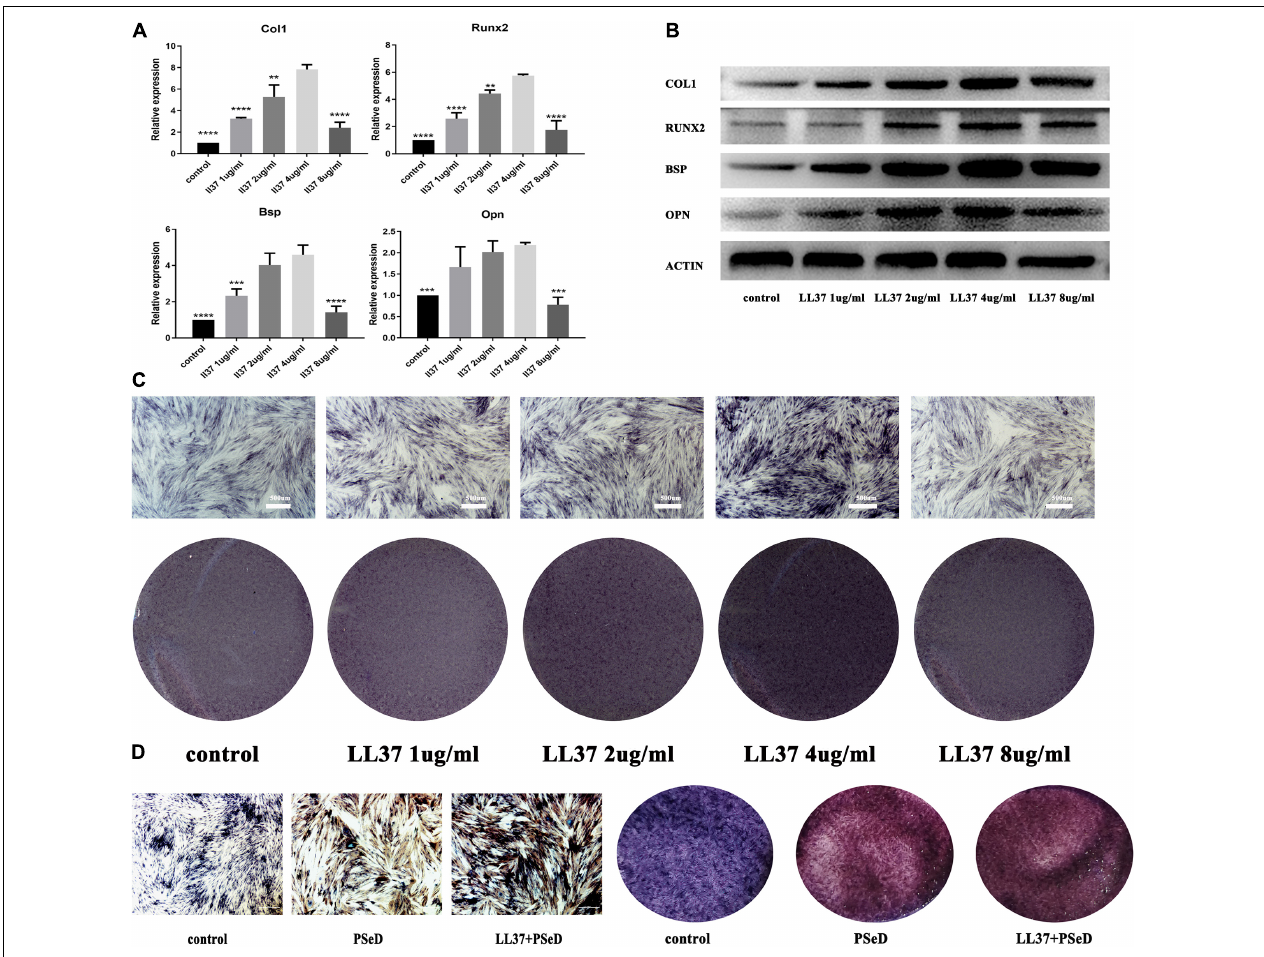
FIGURE 2 | Effects of LL37 on the osteogenic expression levels of human ADSCs in normal DMEM. Human ADSCs were cultured separately in the control group using DMEM. The experimental groups used different concentrations of LL37 (1, 2, 4, 8 µ g/mL). (A) RNA was harvested on day 7. PCR results showed the expression level of mRNA (Col1, Opn, Runx2, Bsp) reached a peak at 4 µ g/mL concentration ( n = 3, compared to 4 µ g/mL concentration group, unpaired t -test, * p < 0.05, ** p < 0.01, *** p < 0.001, **** p < 0.0001). (B) Proteins were extracted on day 7. Western blotting results suggested that 4 µ g/mL of LL37 was most effective in promoting osteogenic protein expression (Col1, Opn, Runx2, Bsp). (C) Results of ALP on the 7th day also supported the protein and RNA expression data. (D) ALP staining results indicated that the combination of PSeD and LL37 can effectively promote